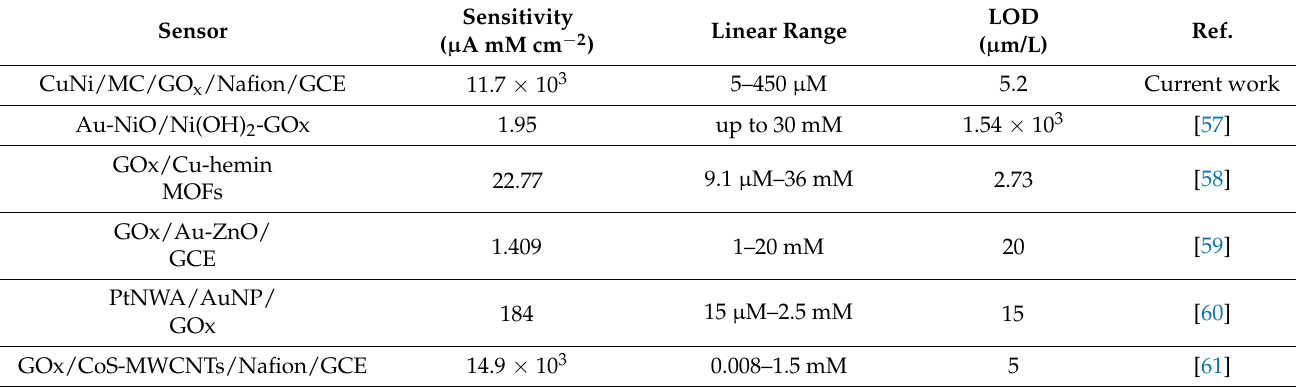
Table 1. Comparative study of the as-prepared electrode with enzymatic electrochemical glucose